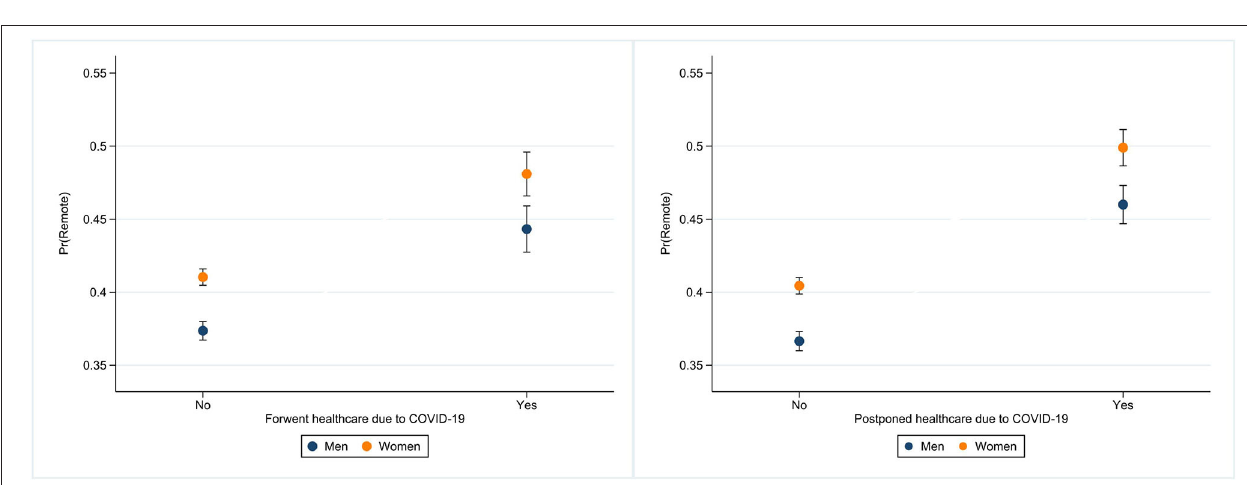
FIGURE 2 | Estimated probabilities of remote medical consultations for men and women and healthcare forgone or